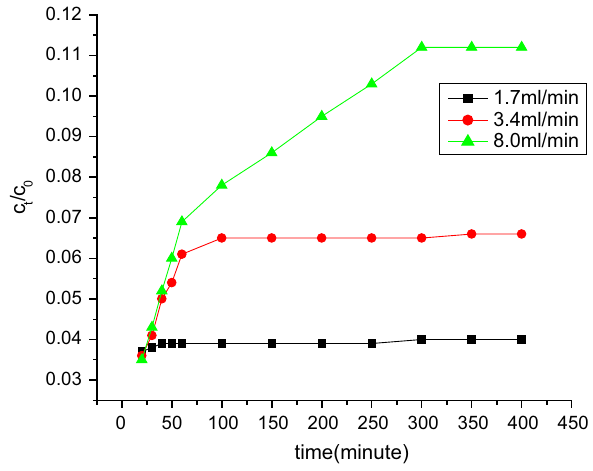
Fig. 5 Breakthrough curve of the effect of different flow rate on fluo- ride adsorption onto banana peel dust ( C 0 = 10.0 mg/L, Z = 0.9 cm,